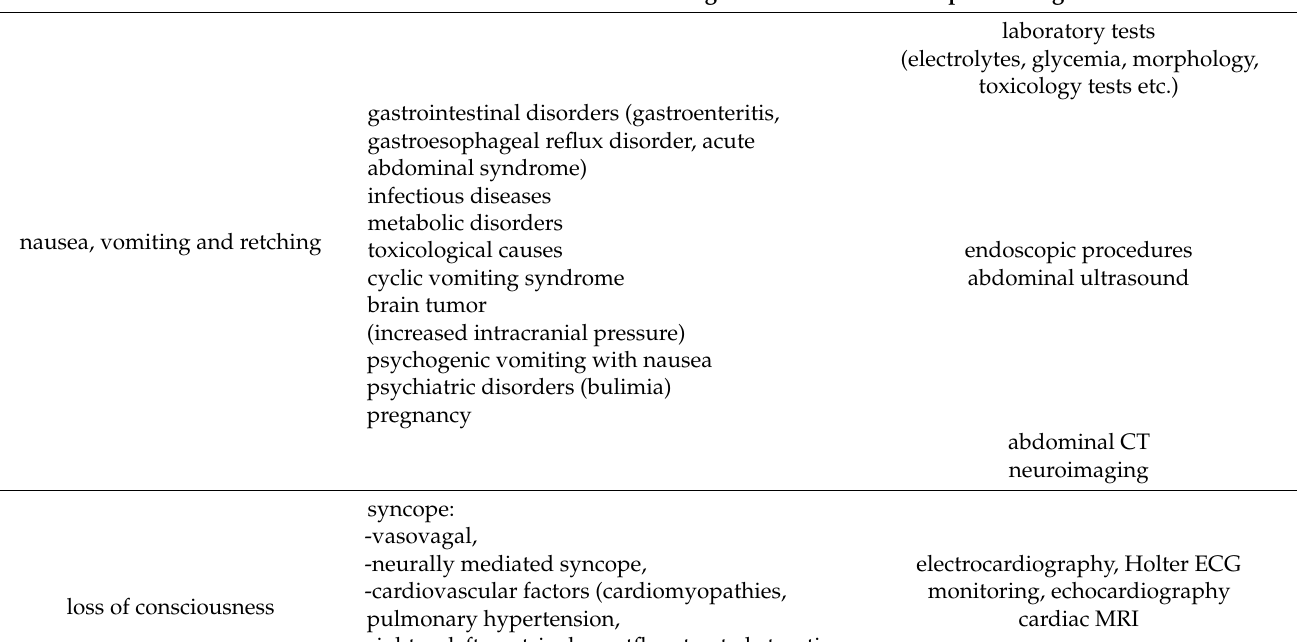
Table 4. This table demonstrates clinical manifestations in PS, potential disorders that present similar clinical features and may mimic SeLEAS. Proposed diagnostic procedures are